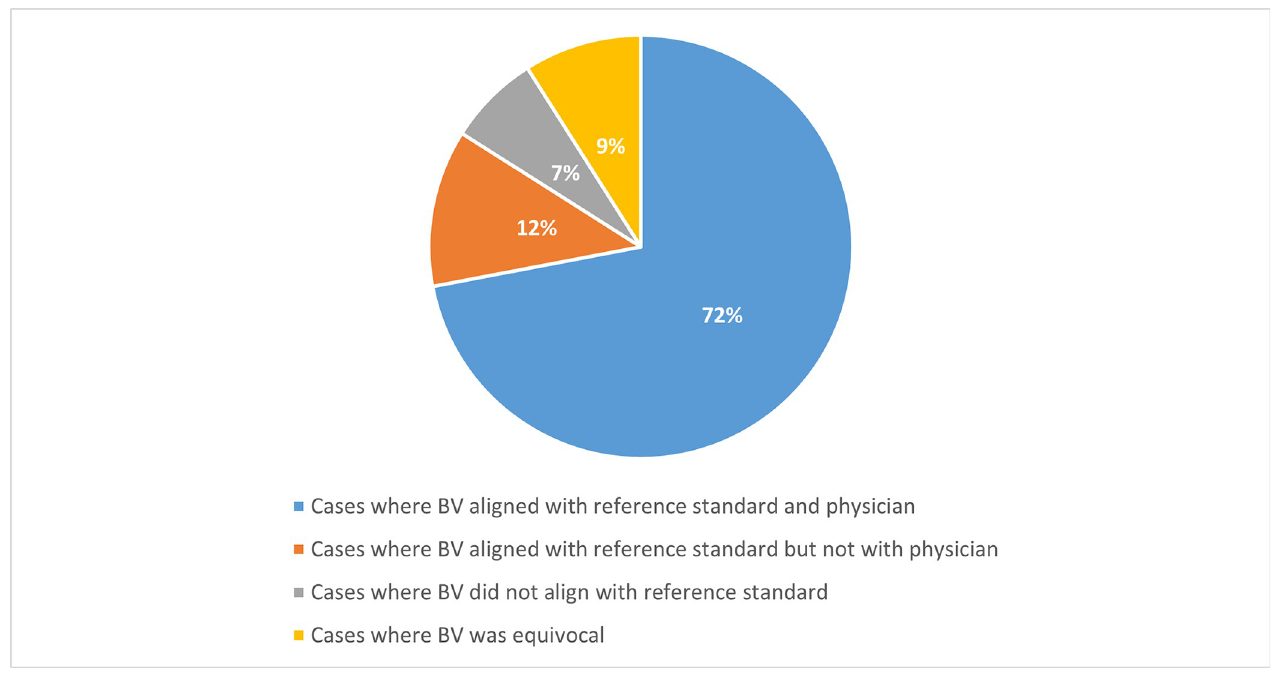
Fig 2. BV score versus adjudication-based reference standard diagnosis and physician label. Data are shown for the primary (reference standard bacterial/ viral) cohort for the cases with completed questionnaires; n = 208.